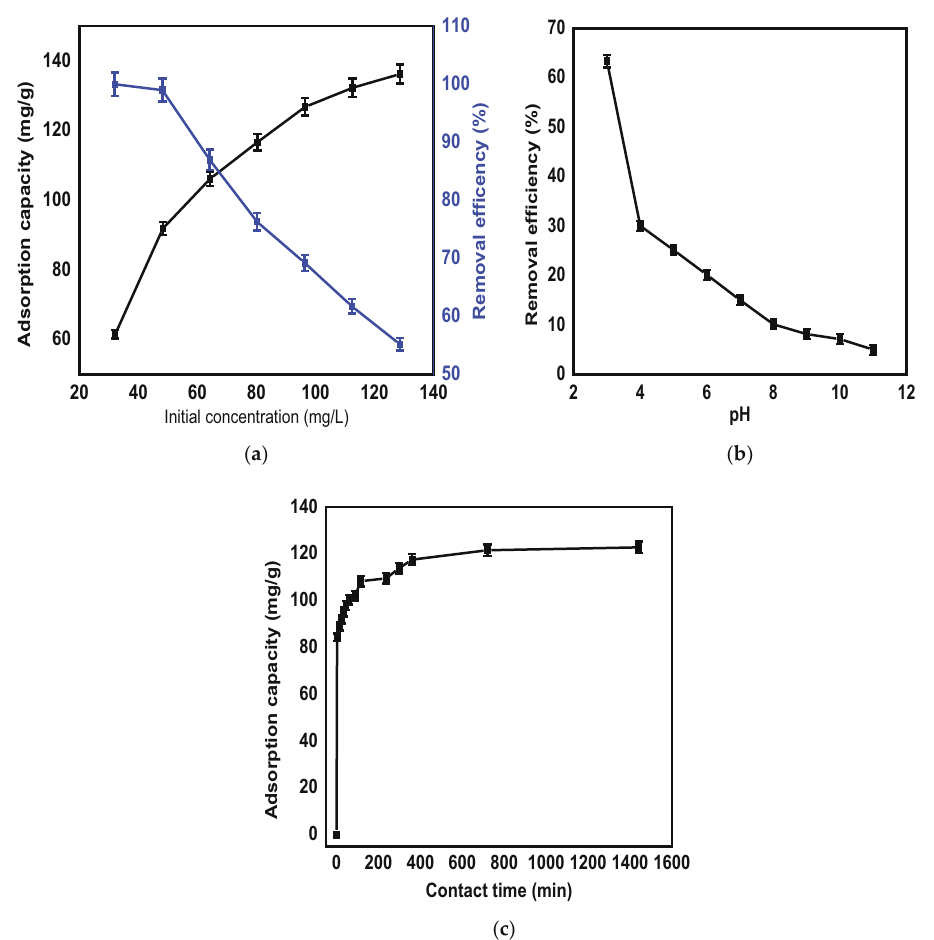
Figure 4: The e ff ect of pH ( a ) , initial concentration ( b ) , and contact time ( c ) on the removal of Cr ( VI ) ions over the surface of PDA/NC